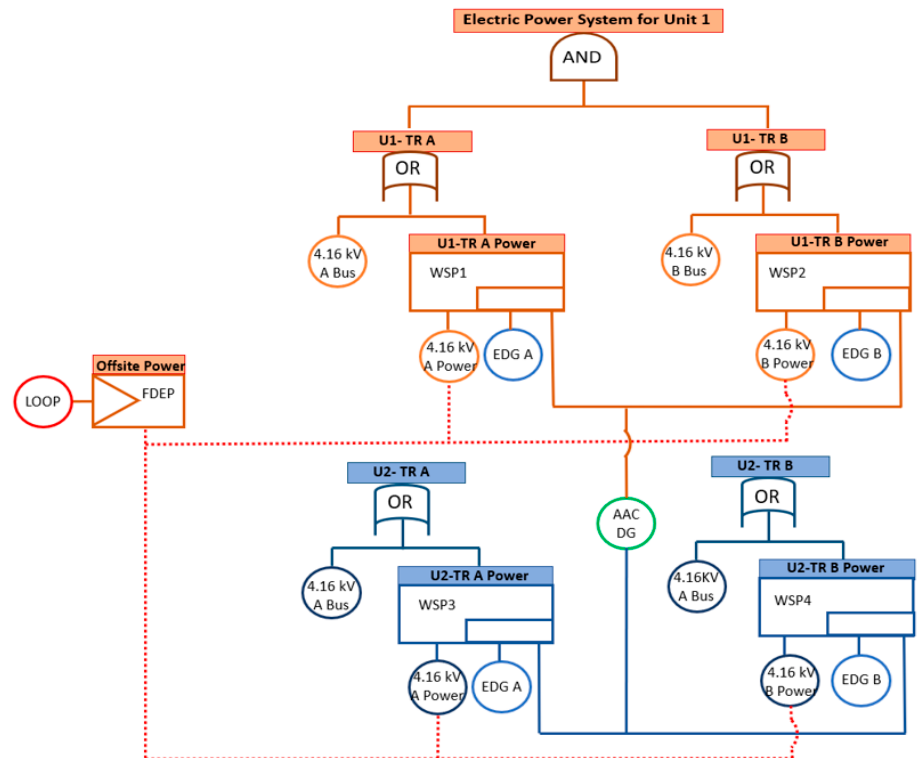
Figure 7. DFT for determining AAC DG priority in the EPS.